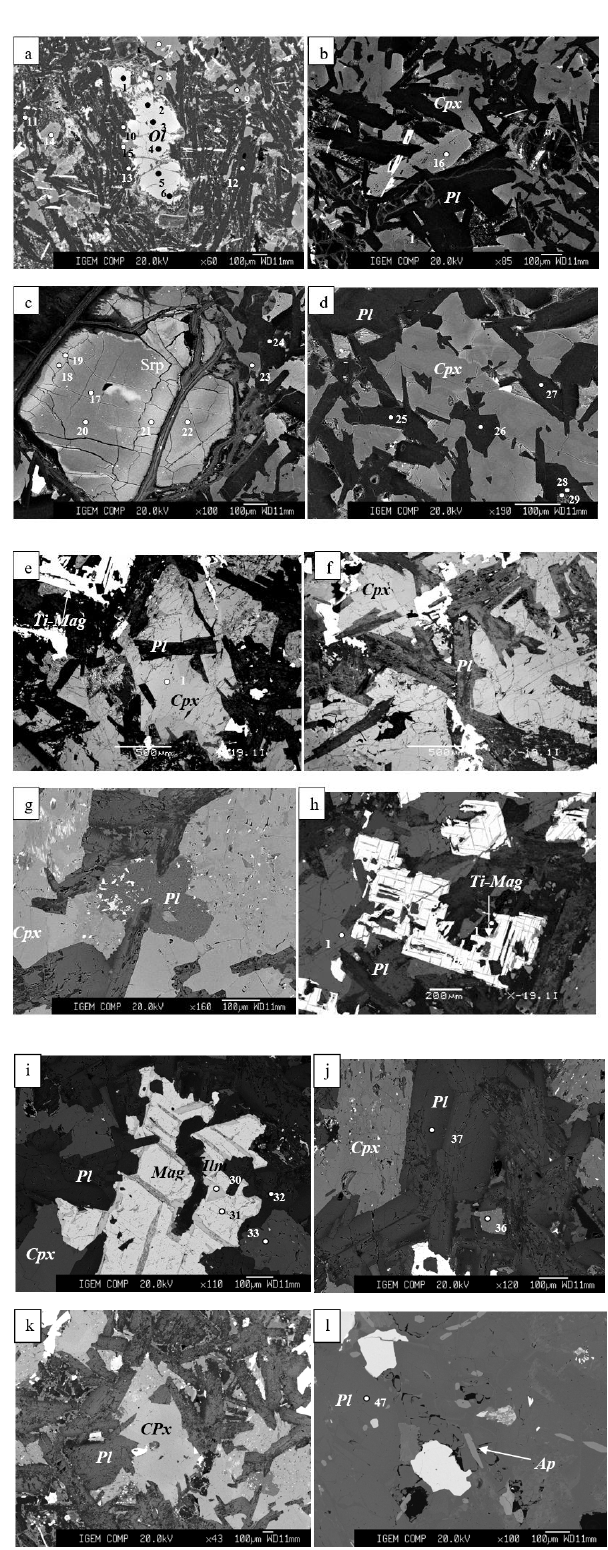
Figure 13. BSE images of the gabbro-dolerites from the Ergalakhsky complex ( a ) Norilsk-type intrusion, ( b – d ) sample X-32; Kureysky complex, Khalil intrusion, ( e – h ) sample X-19, ( e ) poikilophytic structure, ( f , g ) poikilophytic + doleritic structure, ( h ) titanomagnetite crystals in gabbro-dolerite, ( i , j ) sample X-35; Katangsky complex, ( k , l ) sample X-10. Minerals are Cpx : clinopyroxene, Pl : plagioclase, Ol : olivine, Srp : serpentine, Ap : apatite. Point numbers correspond to those in Table 4. The reference object of the Kureysky complex is the Dzhaltulsky massif located several kilometers south of the Kulyumber area. We have analyzed samples from the borehole OKG-13. Olivine from one sample corresponds to the average value of the olivine compositions in the Kylyumber massif: it is characterized by very low concentrations of calcium and nickel (0.07–0.17 wt.% CaO and 0.03–0.06 wt.% NiO) at the same Fo 72–73 of the mineral. Pyroxene is more magnesian-rich (Mg# = 77–78). Intrusions of the Katangsky complex are usually composed of fine-medium-grained homogeneous gabbro-dolerites and olivine-bearing gabbro-dolerites. They have usually a dolerite, poikilophytic structure where plagioclase laths (0.1–0.3 microns) are enclosed in large grains of pyroxene (1–1. 5 mm). The composition of olivine in olivine gabbro-dolerites (sample X-15) is close to the olivine composition from the Kureysky complex but differs in higher nickel contents (up to 0.19 for Fo 73 ; it is close in composition to olivine from the Norilsk 1 intrusion. Plagioclase changes from An 56 to An 70 . The Mg# number of clinopyroxene varies from 53 to 73 and orthopyroxene from 58 to 69. Magnetite contains 12–14 wt.% TiO 2 . The mineral composition of the Khalil intrusion was studied in the sample X-19 and X-35 (Table 4). The compositions of rock-forming minerals from the Katangsky complex will be described in the second part of the article.